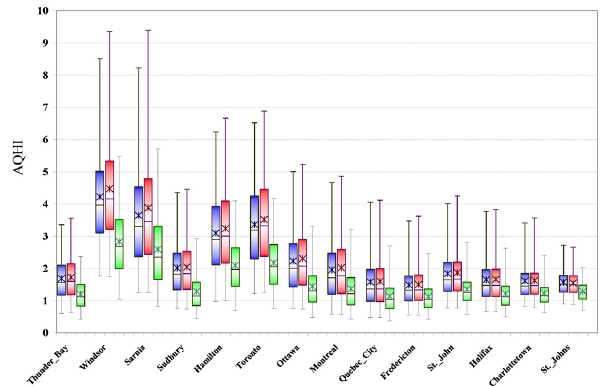
Fig. 12. As in Fig. 11, eastern Canadian towns and cities. Note the vertical scale change compared to Fig. 11.